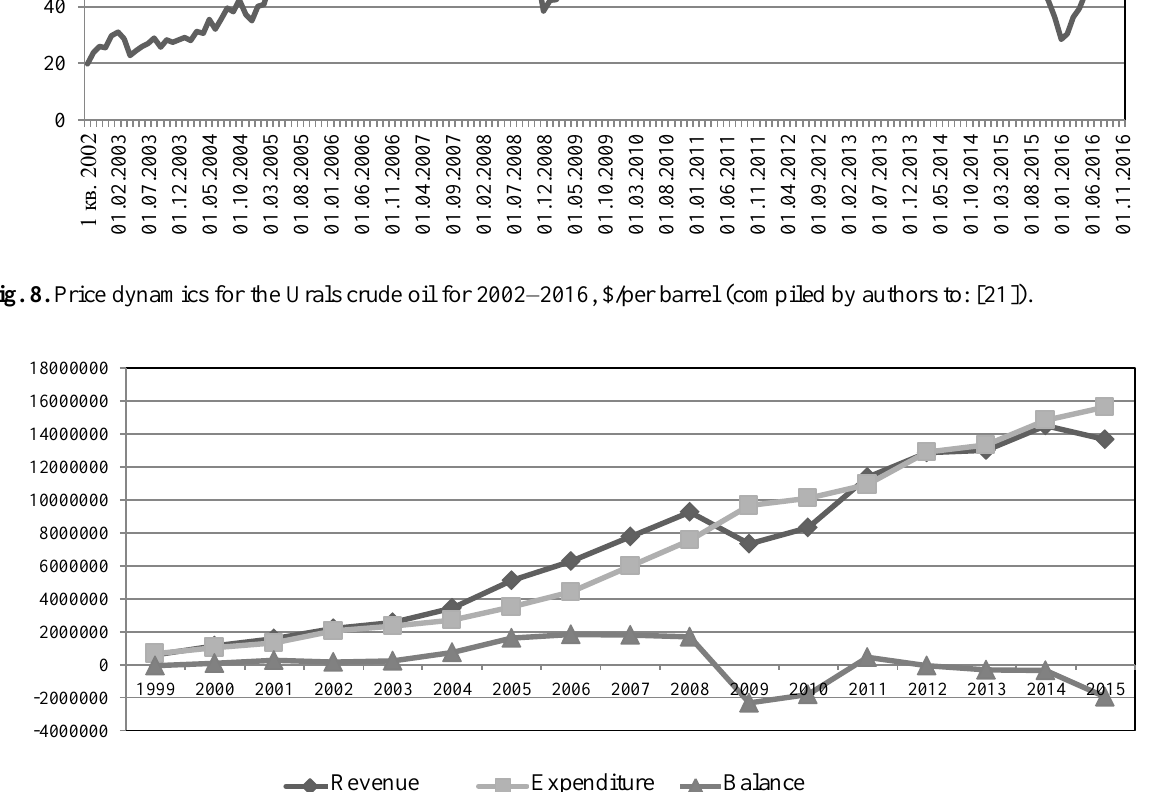
Fig. 9. The federal budget balance for 1999–2015, in mln rubles. (compiled by authors to: